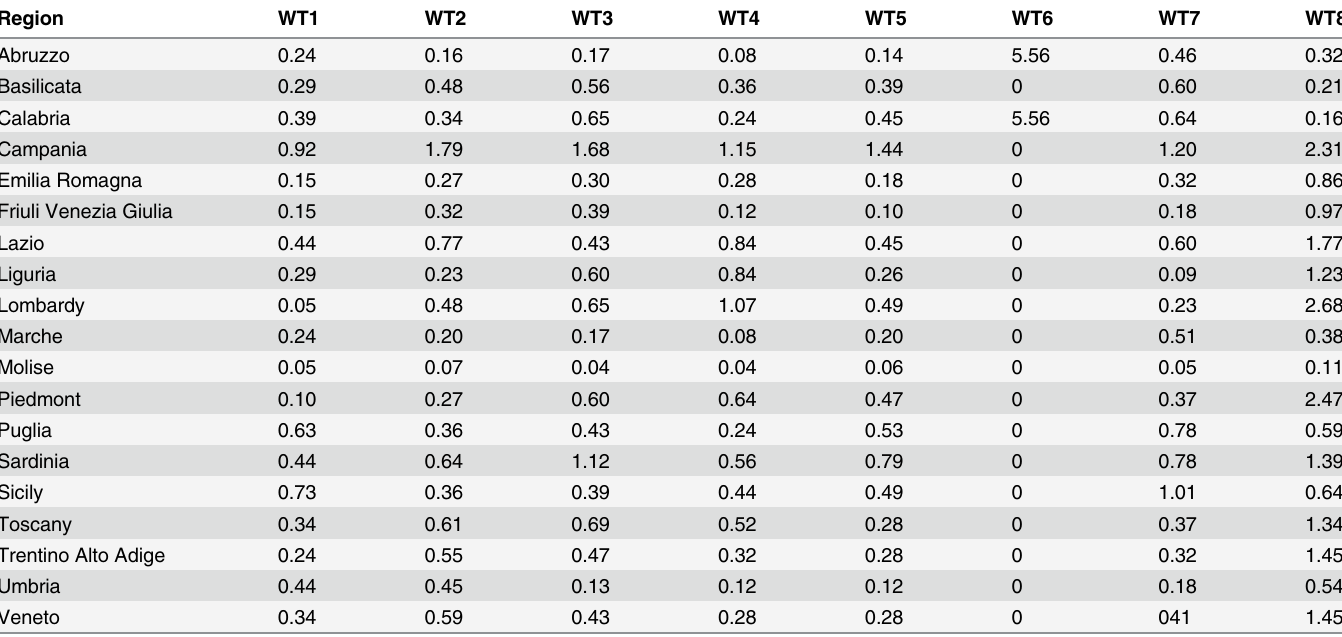
Table 4. Percentage of events for each region and for each WTs.